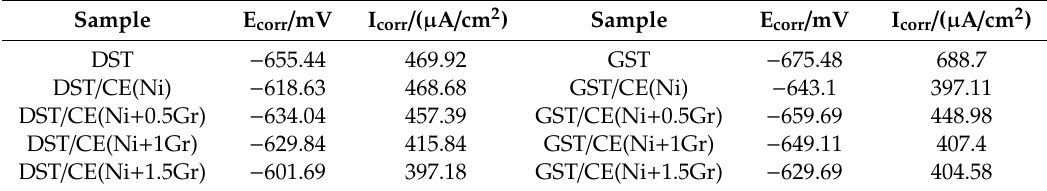
Figure 9. Tafel curve of groove surface texture obtained under di ff erent conditions. Table 4. Corrosion parameters for dimple and groove surface texture base under di ff erent